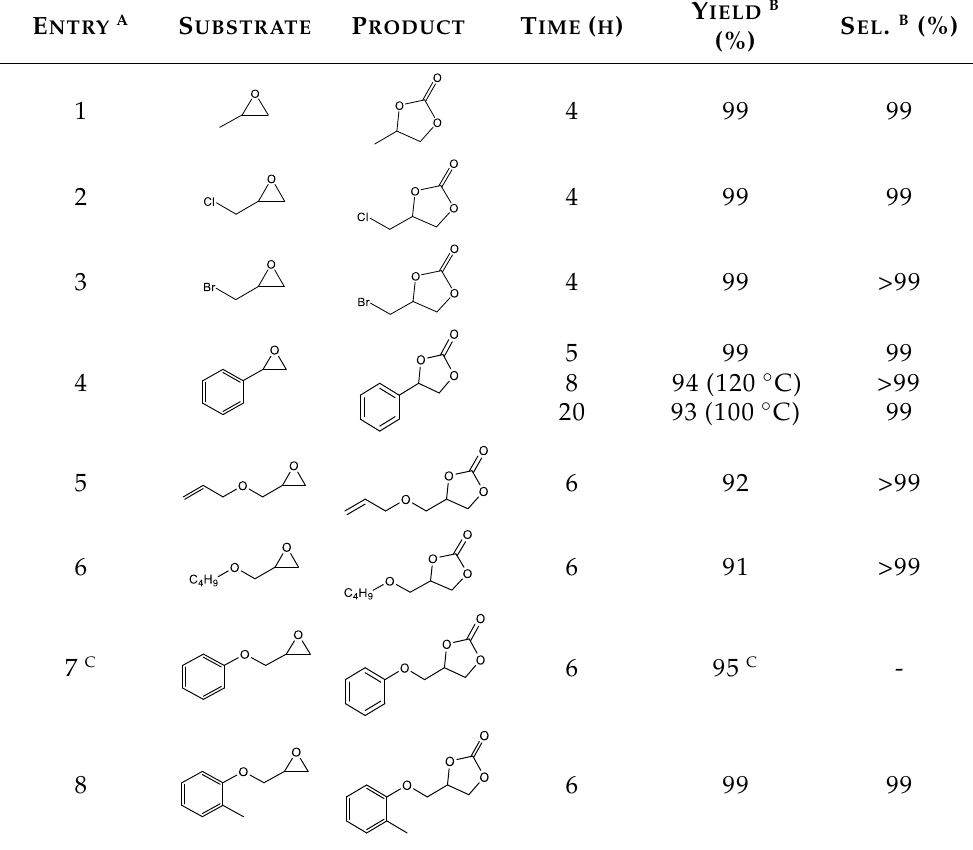
Figure 7. Effect of yield and selectivity as a function of ( a ) temperature, styrene oxide (5 mmol), 0.1 MPa CO 2 , 5 h, [HCP-CH 2 -Im][Cl]-1 (25 wt%); ( b ) mass ratio of catalyst to SO, styrene oxide (5 mmol), 0.1 MPa CO 2 , 140 °C, 5 h; ( c ) reaction time, styrene oxide (5 mmol), 0.1 MPa CO 2 , 140 °C, [HCP-CH 2 - Im][Cl]-1 (25 wt%).